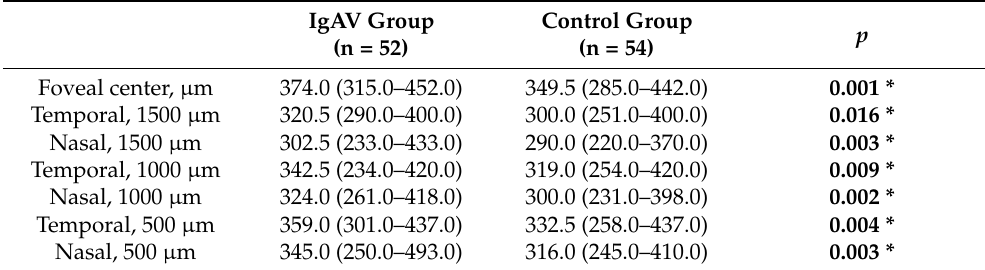
Figure 2. ( a ) Choroidal thickness measurements obtained by spectral-domain optical coherence tomography in a child with immunoglobulin A vasculitis. ( b ) Choroidal thickness measurements in a child from the control group. Images were obtained by averaging multiple B-scans from same position in both groups. Table 2. Comparisons of Choroidal Thicknesses in the Right Eyes of Immunoglobulin A Vasculitis and Control Groups.